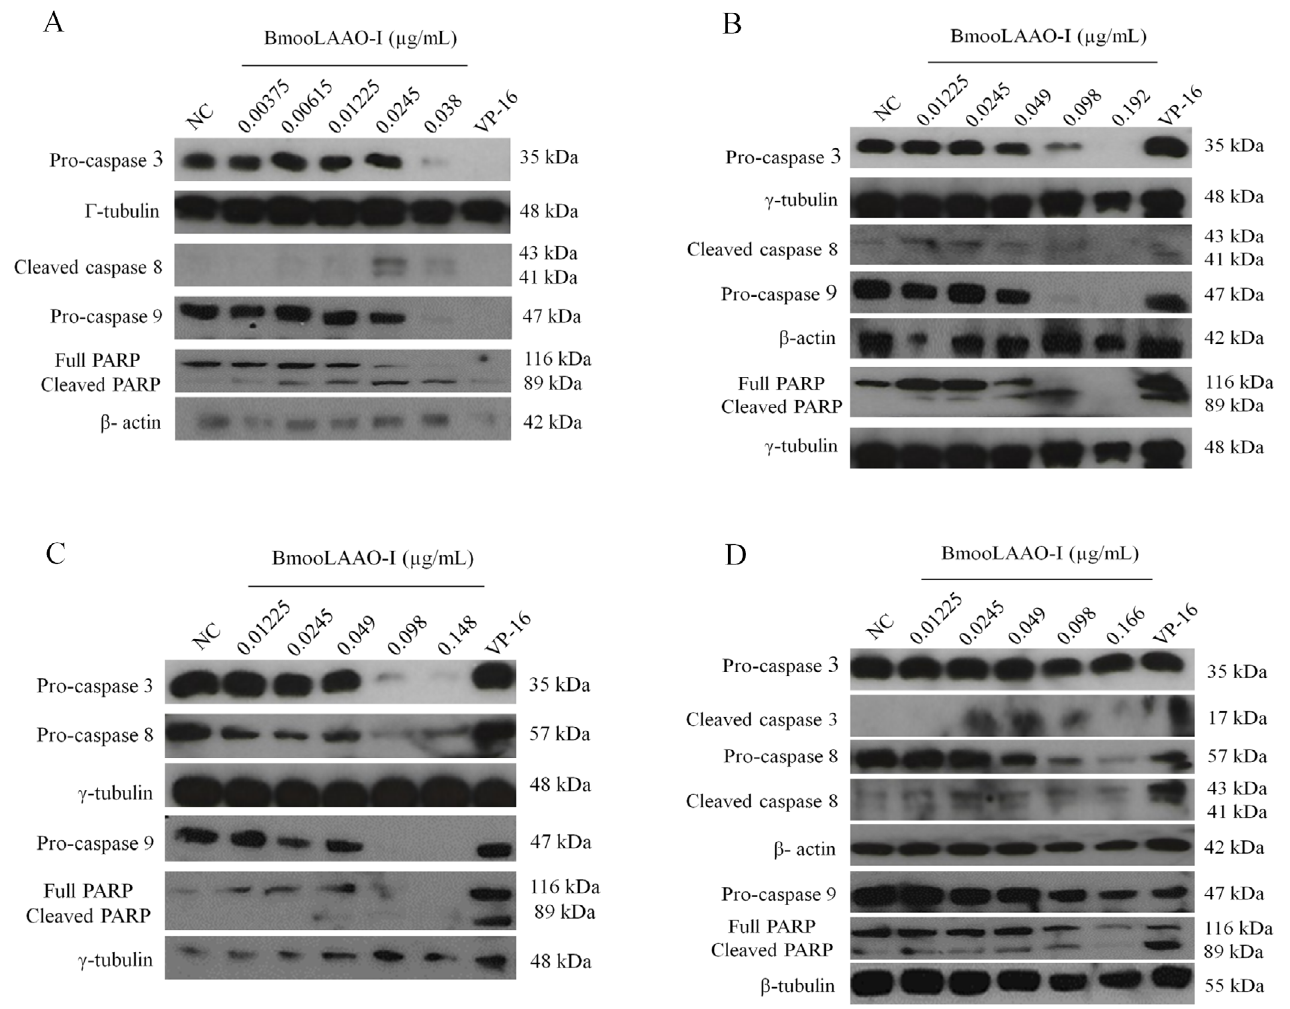
Figure 4. Western blotting analysis of BmooLAAO-I-induced expression of cleaved caspases in tumor cell lines. (A) The levels of caspases 3, 8 and 9 were determined in HL-60, (B) HL-60.Bcr-Abl, (C) K562-S, and (D) K562-R cells after 24 h of treatment with BmooLAAO-I. Decreased pro-caspase expression and increased expression of active (cleaved) forms indicates caspase activation. NC: negative control (untreated cells). VP-16: etoposide (positive